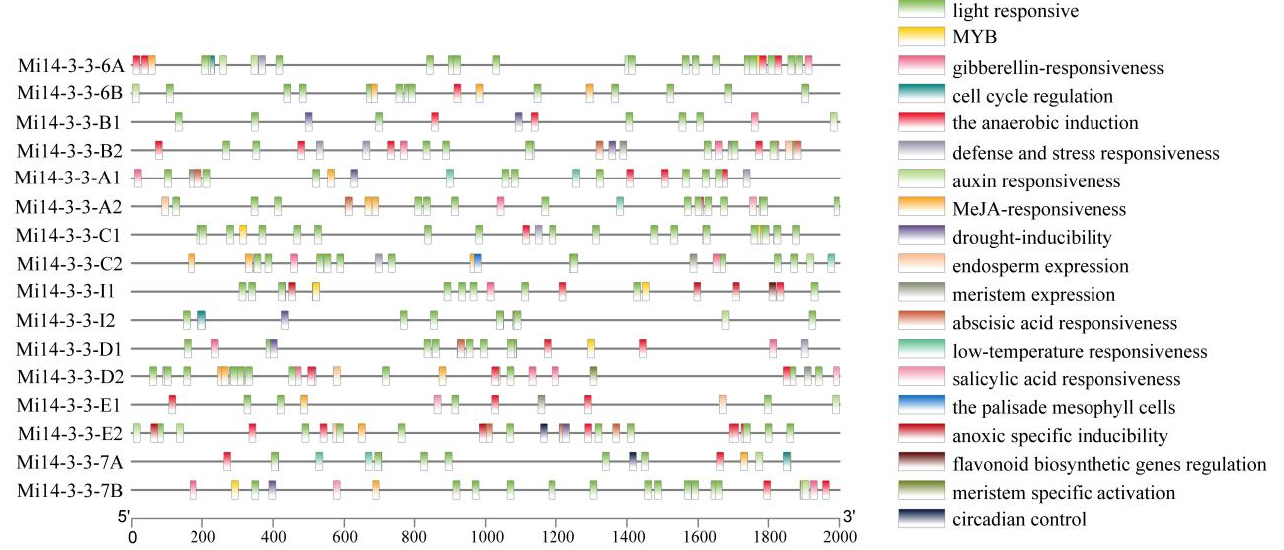
Figure 6. Visualization of the results of an analysis of cis-regulatory elements within the promoters of Mi14-3-3 gene family members.